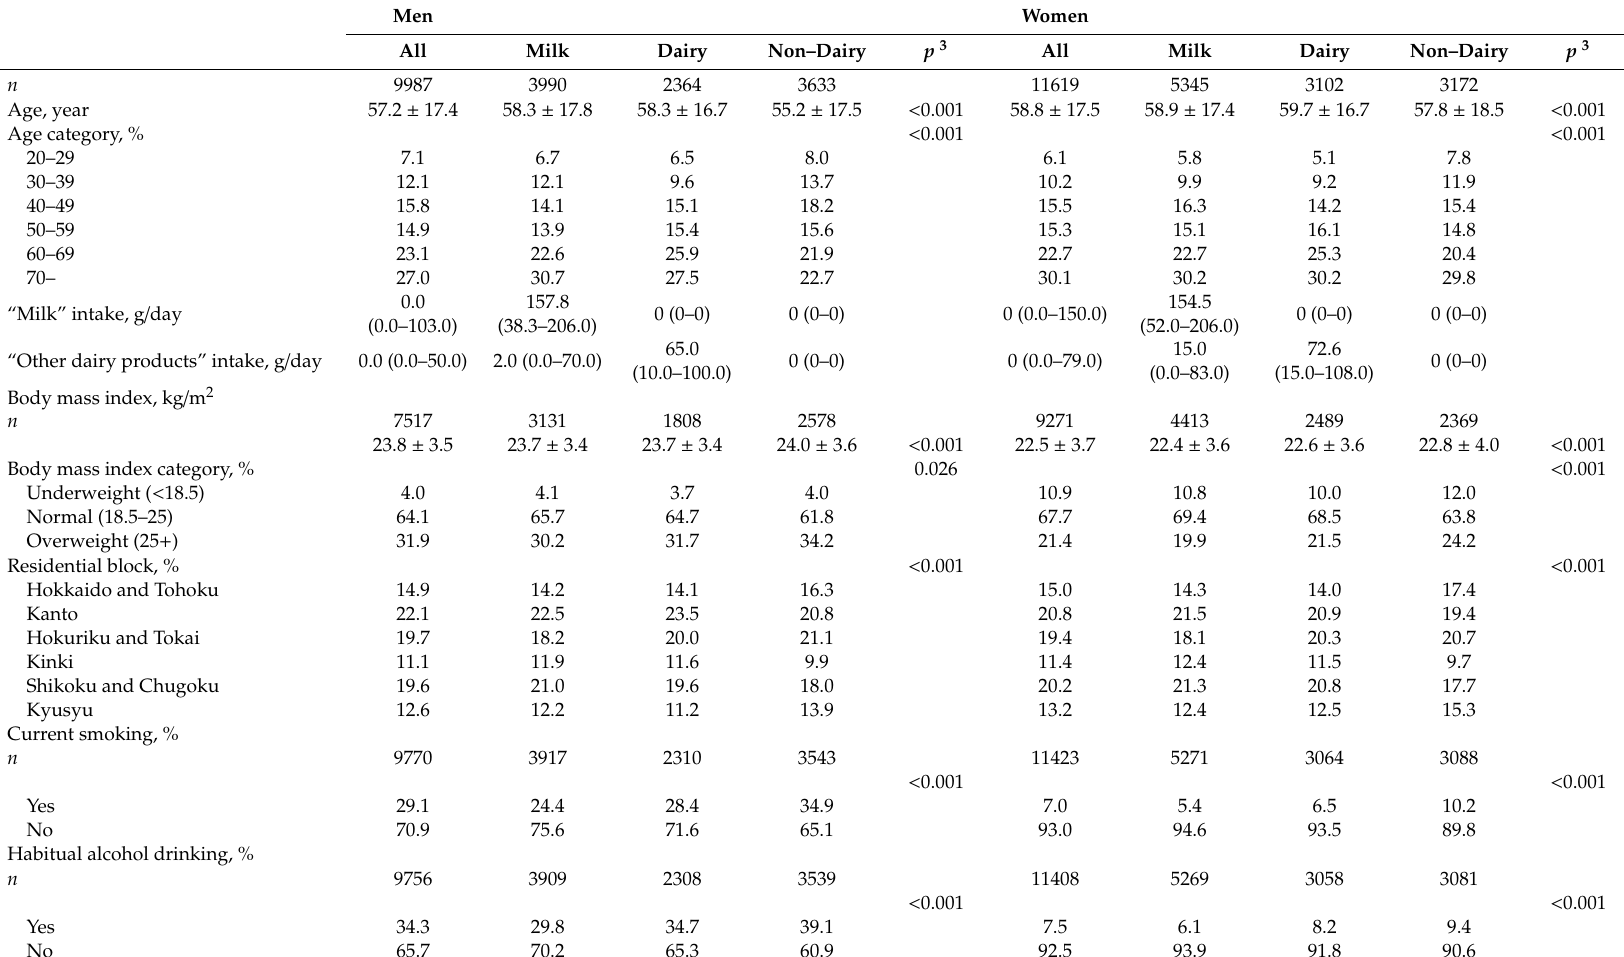
Table 2. Basic characteristics of 9987 men and 11,619 women according to dairy intake status 1,